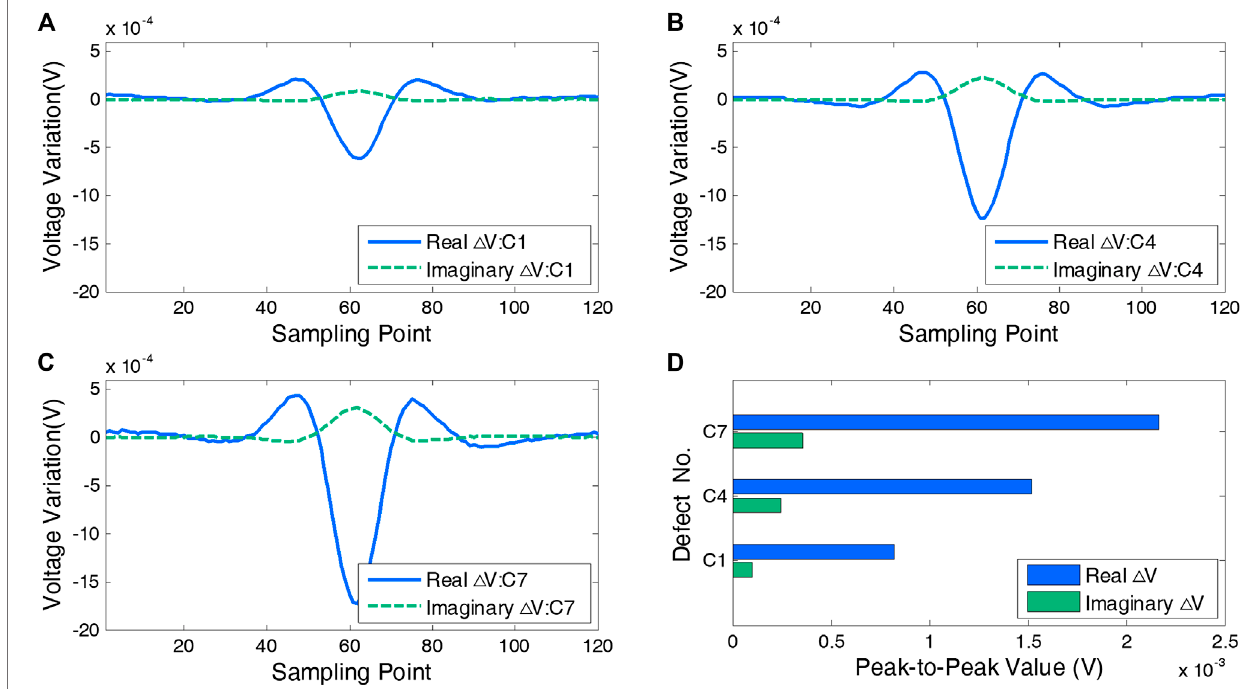
FIGURE 9 | Signal strength comparison: (A) real and imaginary parts of voltage difference for C1 notch; (B) real and imaginary parts of voltage difference for C4 notch; (C) real and imaginary parts of voltage difference for C7 notch; (D) comparison of peak-to-peak values.